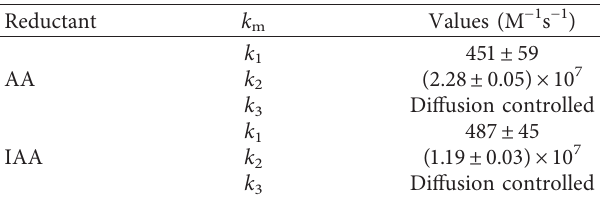
Table 2: Rate constants for the rate-determining steps at 25.0 ° C and 1.0M ionic strength.